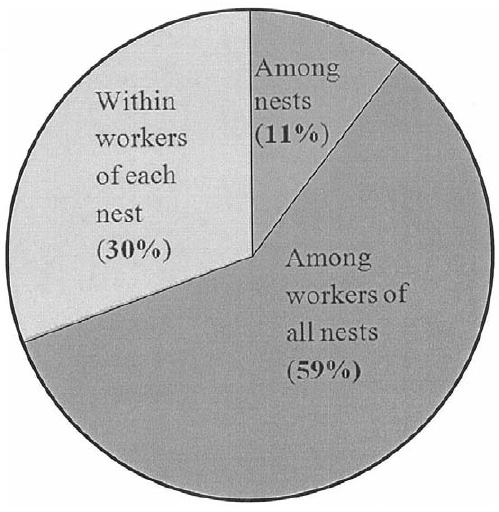
Figure 2. The hierarchical AMOVA based on microsatellite markers for showing the genetic differentiation of A.dorsata solitary nests.